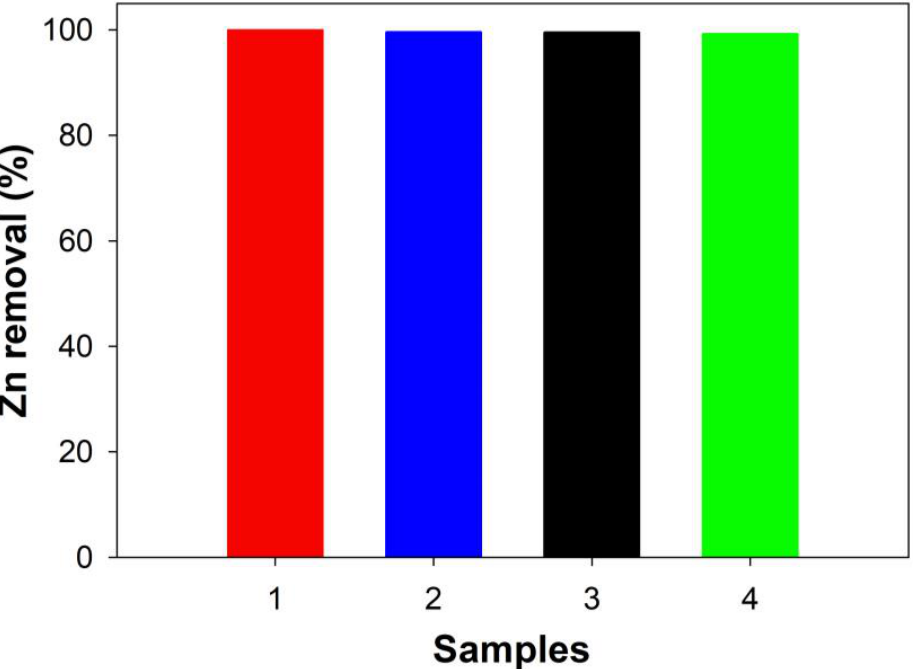
Figure 4. Overall Zn removal (%) of the activated sludge (AS) at increasing Zn concentrations: (1) AS; (2) AS + 200; (3) AS + 300; (4) AS + 400.